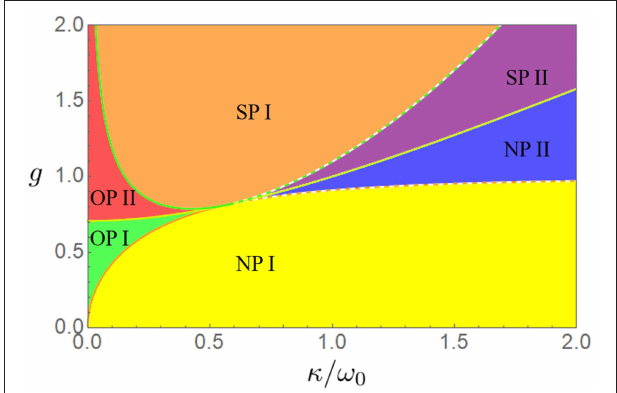
FIGURE 2 | The phase diagram of the dissipative QRM together with PT symmetric structure. The normal phase, the superradiant phase and the oscillating phase are denoted by the letters “NP,” “SP,” and “OP,” respectively. To illustrate more details of the phase diagram, the phases NP I, NP II, SP I, SP II, OP I, and OP II are plotted with yellow, blue, orange, purple, green, and red blocks,